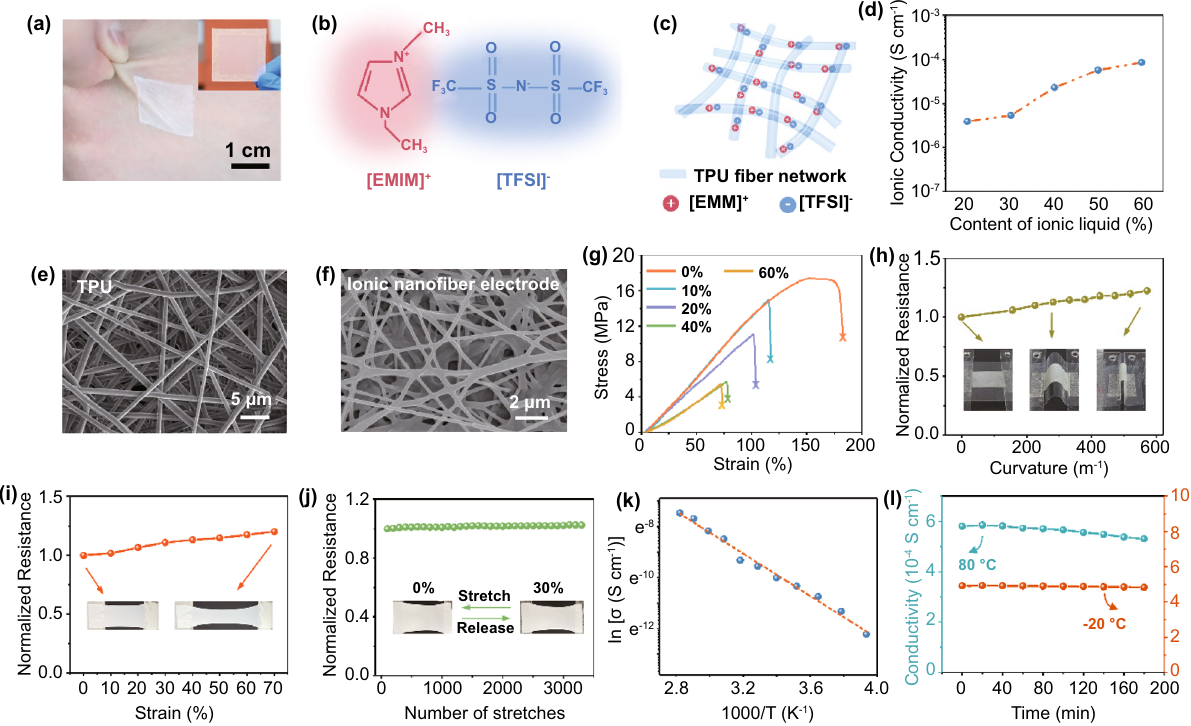
Fig. 2 Electro-mechanical properties of ionic nanofiber electrode. a Photograph of the ITM attached on the human hand; b chemical structural formula of ionic liquid ([EMI][TFSI]); c conductive mechanism of the ionic nanofiber electrode based on TPU scaffold and the ionic liquid; d influence of EMITFSI concentration on the conductivity of the ionic nanofiber electrode; e , f SEM images for pure TPU nanofibers and the ionic nanofiber electrode (ionic liquid of 60 wt%); g stress–strain curves when increasing concentration of EMITFSI in ionic nanofiber electrode; h electric resistance of the ionic nanofiber electrode at varying bending curvatures from 0 to 570 m −1 ; i electric resistance of the ionic nanofiber electrode as a function of uniaxial tensile strain up to 70% stretching; j cyclic stretching test of the ionic nanofiber electrode at strain of 30%; k Arrhenius ionic conductivity (σ) plots of the ionic nanofiber electrode; l thermal stability of the ionic nanofiber electrode at both low (− 20 °C) and elevated (80 °C)